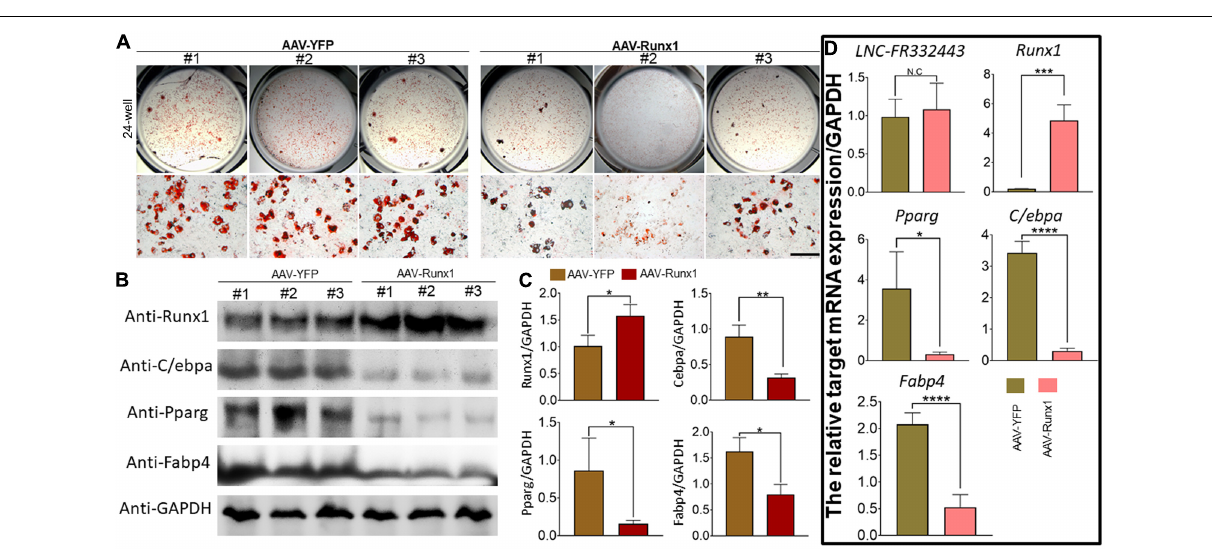
FIGURE 6 | Runx1 overexpression inhibits 3T3-L1 preadipocyte differentiation. (A) Oil red O staining of 3T3-L1 cells transfected with AAV- Runx1 and its control at day 4. Scale bar, 200 µ m. (B) The protein expression levels of Runx1 and the adipogenic markers PPAR γ , C/EBP α and FABP4 in the 3T3-L1 cells transfected with AAV- Runx1 and its control. (C) Quantification data of panel (B) . (D) The mRNA expression levels of Lnc-FR332443, Runx1, PPAR γ , C/EBP α and FABP4 in the 3T3-L1 cells transfected with AAV- Runx1 and its control. All data are presented as the mean ± SEM, N = 6, NS denotes not significant, * P < 0.05, ** P < 0.01, *** P < 0.001, and **** P <